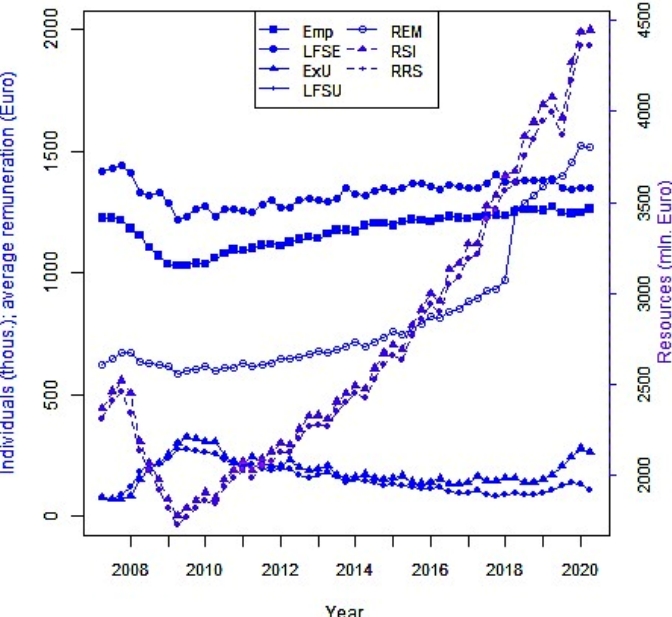
Figure 2. Time series